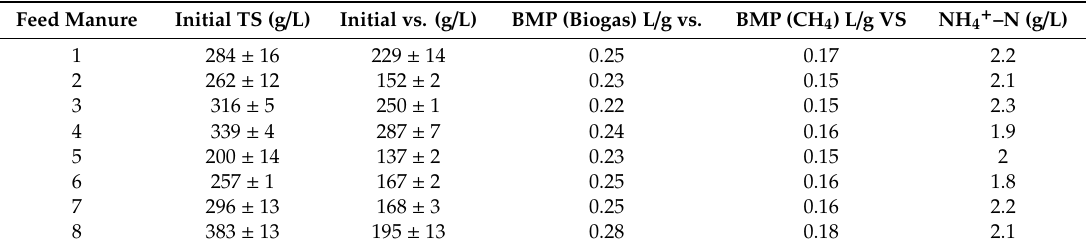
Table 2. Applied feed characteristics before dilution for the feeding periods.